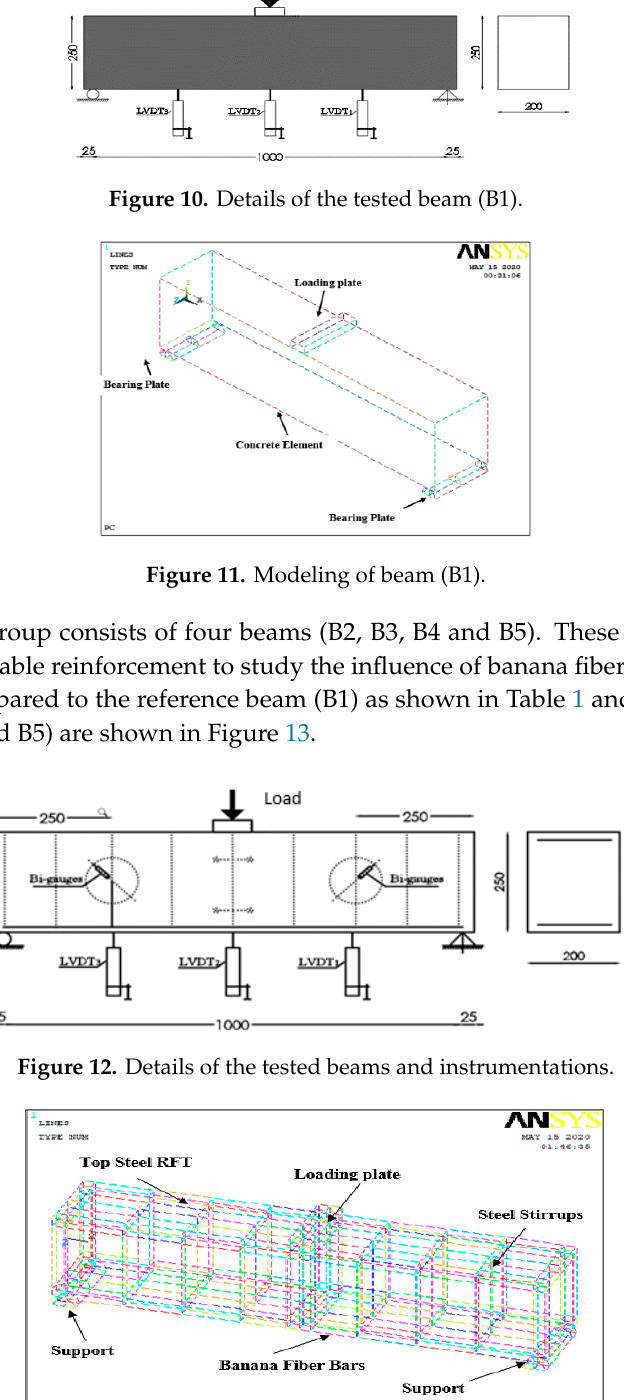
Figure 9. Loading and supports simulation.